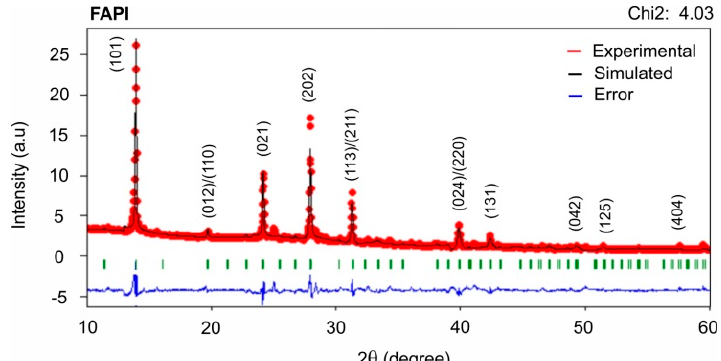
Figure 6. Simulated and experimental XRD patterns of a typical FAPI film (PbI 2 / FAI thickness ratio of 2.2:1).